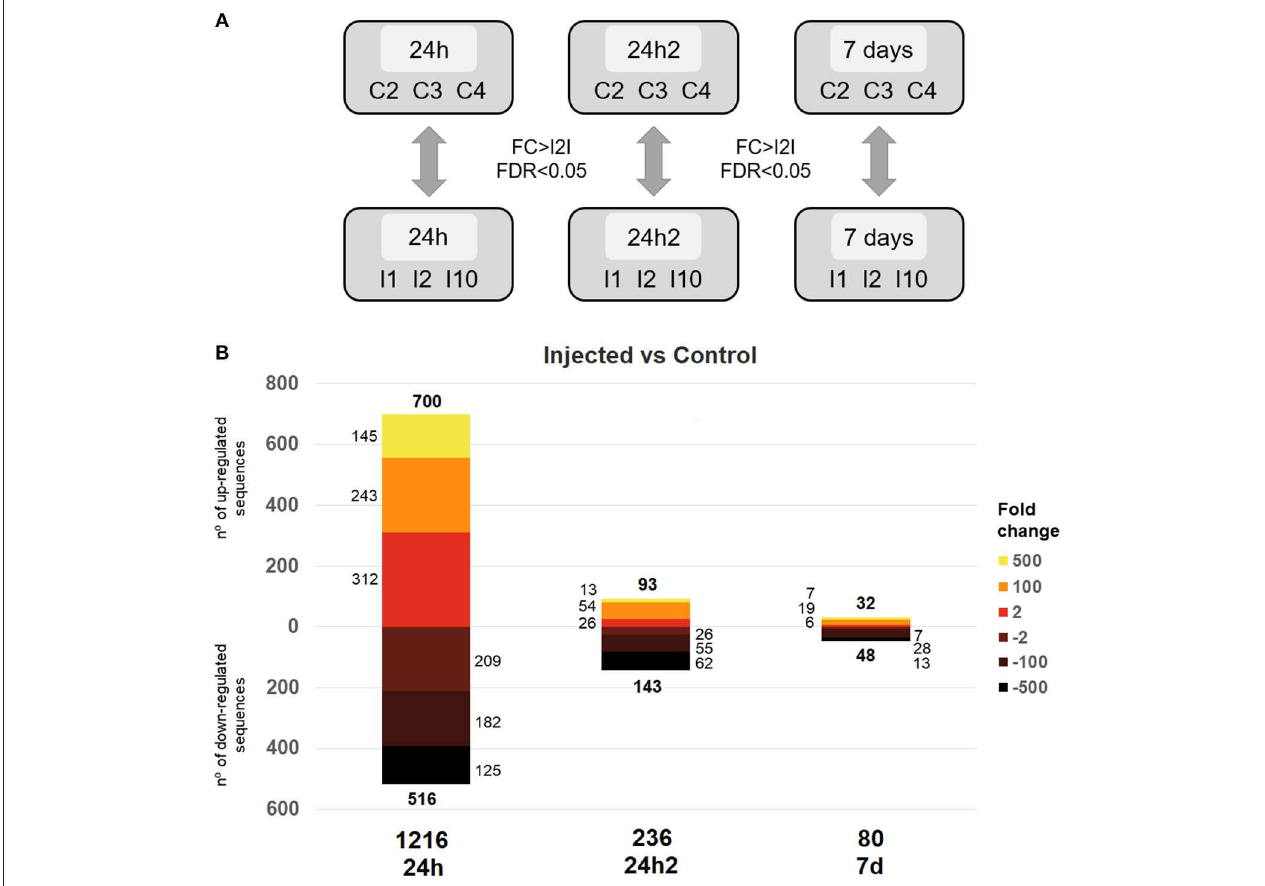
FIGURE 2 | (A) Representative scheme of the comparisons made for the differential expression analysis between injected and control individuals at the analyzed sampling points. The thresholds used to detect statistical significance were a fold change (FC) > |2| and an FDR < 0.05. (B) Distribution of the response magnitudes of the DEGs. Statistically significant gene modulation is shown according to intensity (fold-change) and direction (up- and